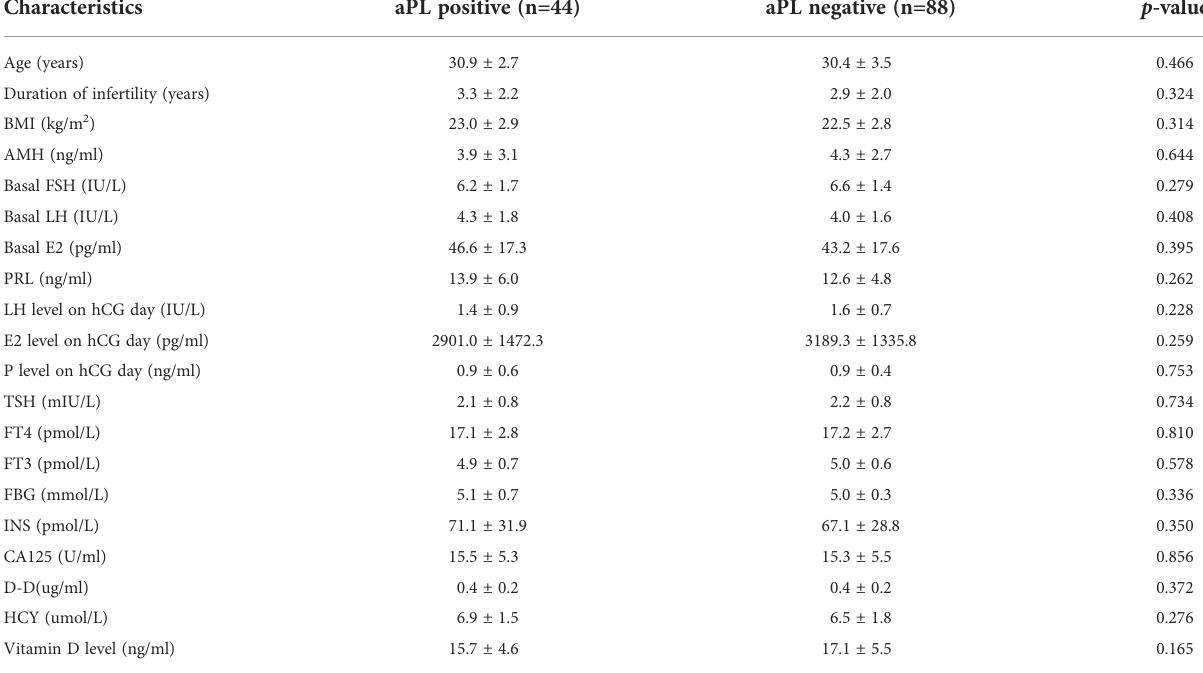
TABLE 1 Baseline of clinical and laboratory characteristics of women with tubal etiology infertility with and without antiphospholipid antibodies (aPL, aCL and/or aB2GPi antibodies).